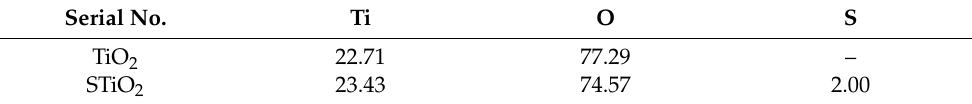
Table 2. The atomic composition (%) of Ti, O and S in pristine TiO 2 and STiO 2 . Serial No.